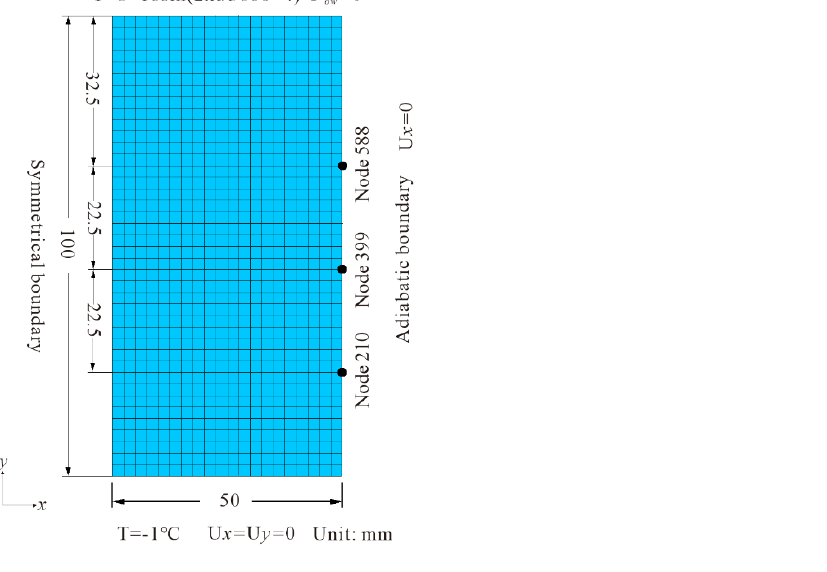
Figure 1. The computational model for one-dimensional thaw consolidation of silty clay and bound- ary conditions. Table 1. Parameters used in the simulation of one-dimensional thaw consolidation of silty clay.